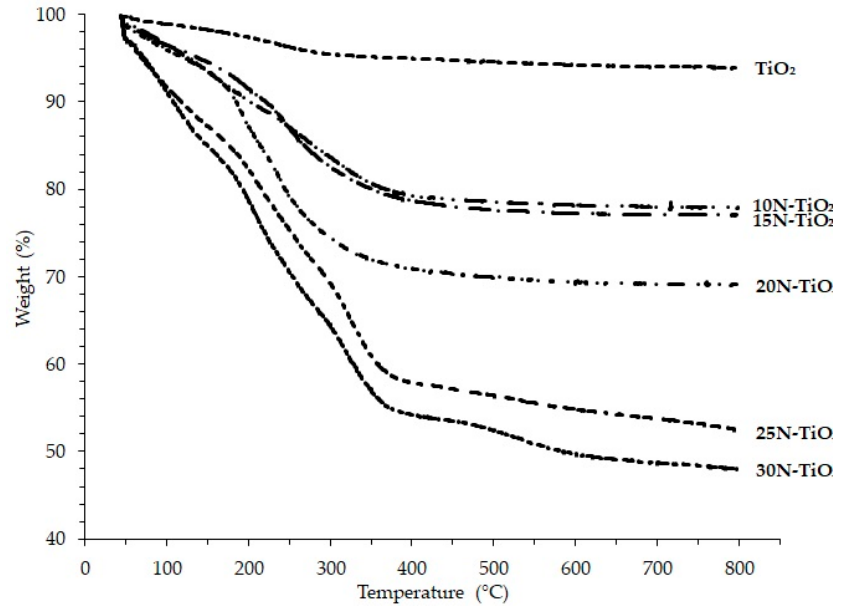
Figure 1. Thermograms of TiO 2 and N–TiO 2 photocatalysts.